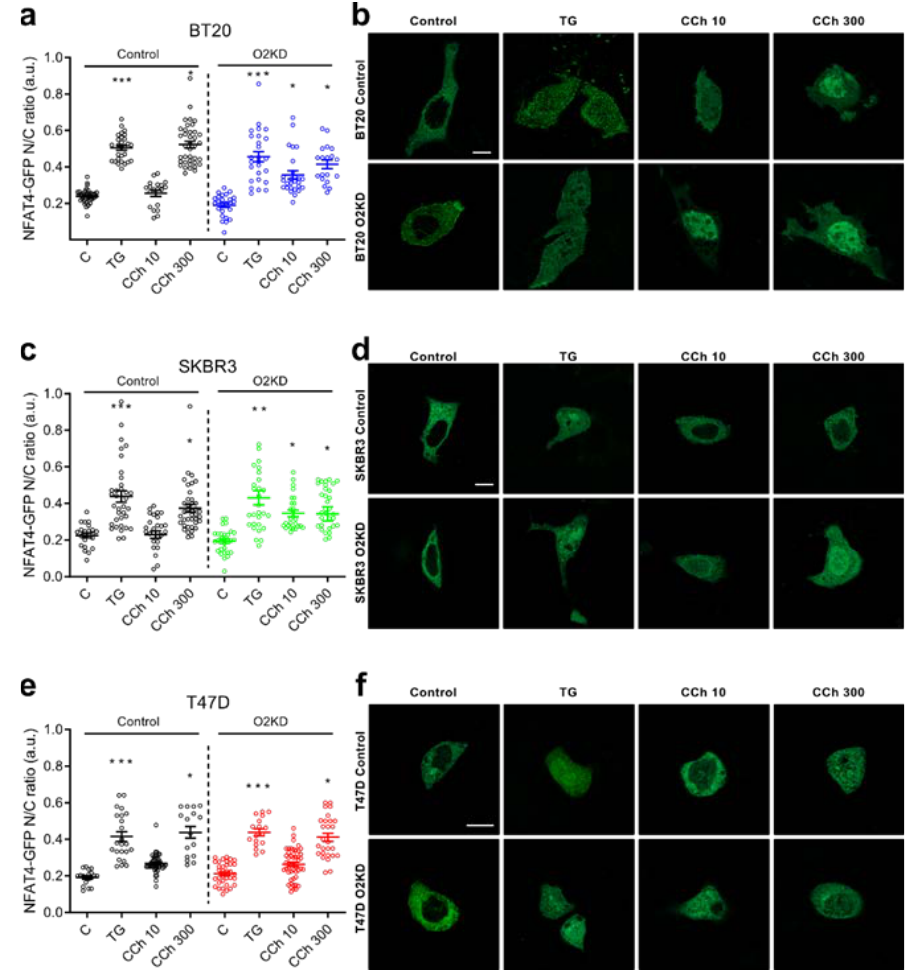
Figure 5. Orai2 knockdown modifies NFAT4 nuclear translocation. BT20 ( a , b ), SKBR3 ( c , d ) and T47D ( e , f ) cells were transfected with esiOrai2 (O2KD) or non-specific siRNA (Control), as indicated, as well as with HA-NFAT4(3-407)-GFP. Cells were stimulated with 1 µ M TG or CCh (10 or 300 µ M). NFAT4 nuclear translocation was determined before (Control) and 30 min after the addition of TG or CCh, and fluorescence was detected using confocal microscopy, as described in Section 4. Scatter plots represent the ratio of nuclear to total NFAT4 and is presented as mean ± SEM ( n = 19–49; n -values correspond to individual cells). Data were statistically analyzed using Kruskal–Wallis test with multiple comparisons (Dunn ´ s test) to cells transfected with scramble plasmids (* p < 0.05, ** p < 0.01 and *** p < 0.001). ( b , d , f ) Representative images of NFAT4 nuclear translocation in BT-20, SKBR3 and T47D cells before (Control) and 30 min after the addition of TG (1 µ M) or CCh (10 or 300 µ M). Scale bar: 10 µ